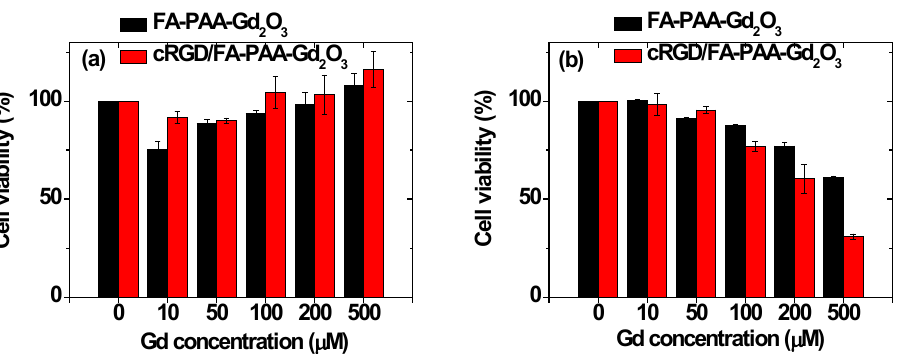
Figure 7. Plots showing viability of ( a ) NCTC1469 (normal) and ( b ) U87MG (tumor) cells after 48 h of incubation with FA-PAA-Gd 2 O 3 and cRGD/FA-PAA-Gd 2 O 3 nanoparticles.